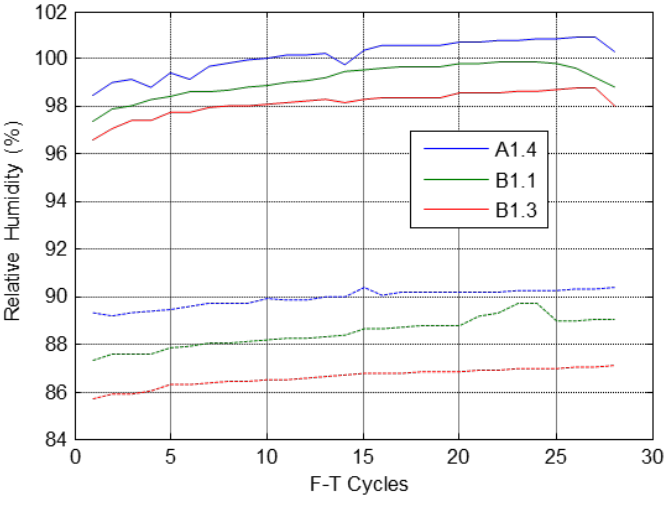
Figure 13. Relative humidity at the freezing (-) and thawing (--)